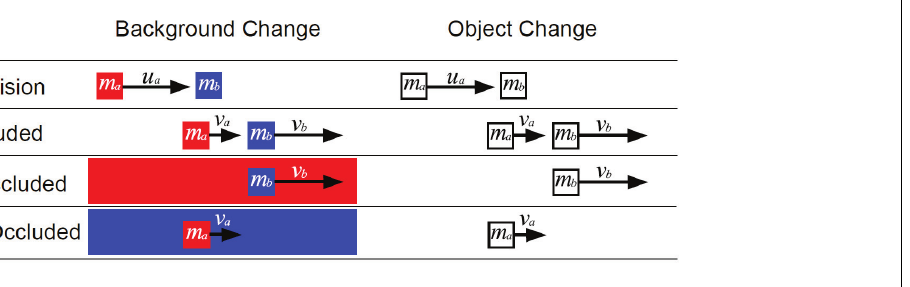
At contact, either the motor (motor occluded), projectile (projectile occluded) or neither object (unoccluded) disappeared. The method of disappearance differed in the background change and object change